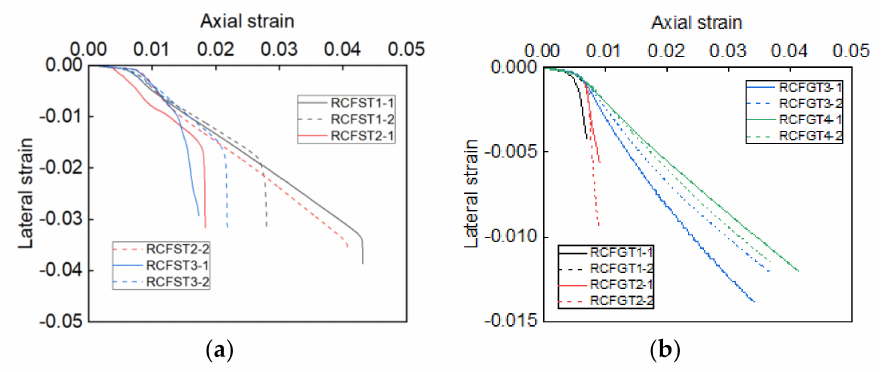
Figure 14. The axial strain-lateral strain curves. ( a ) Core RAC in steel tubes; ( b ) core RAC in GFRP